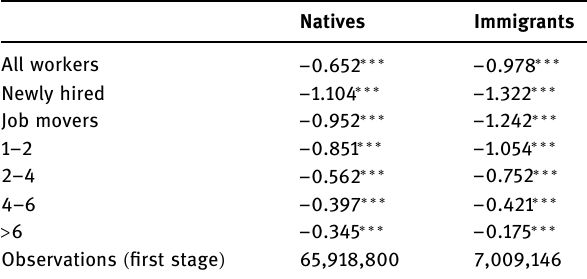
Table A5: Wage cyclicality for selected samples, single regression with a dummy for nationality Natives Immigrants